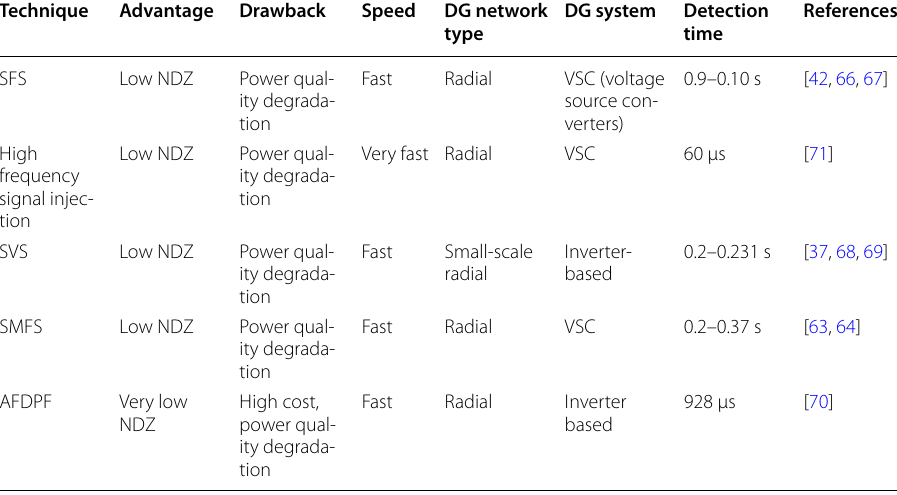
Table 3 Summary of various active island detection technique